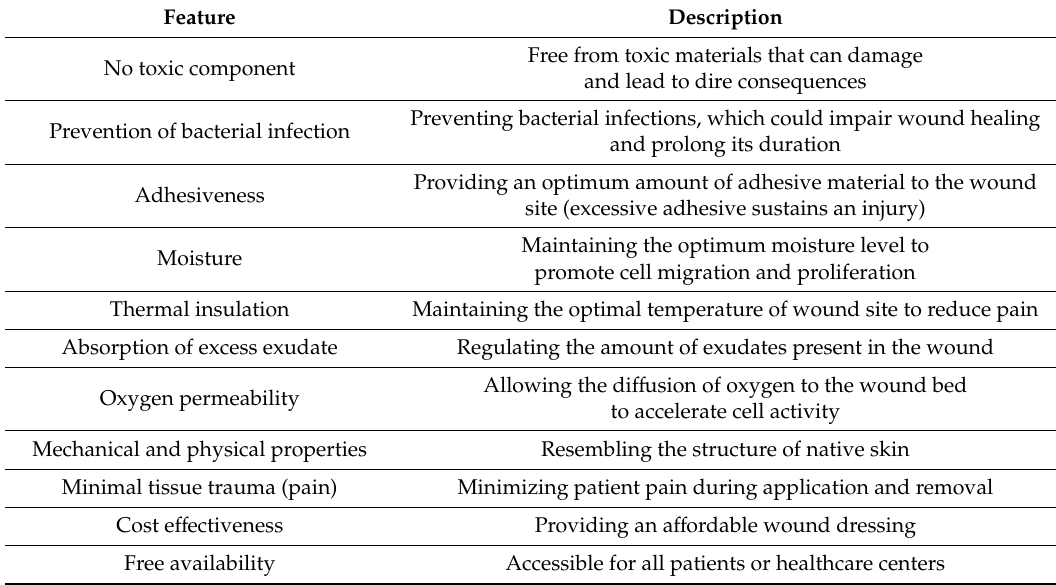
Table 1. Characteristics of an ideal wound